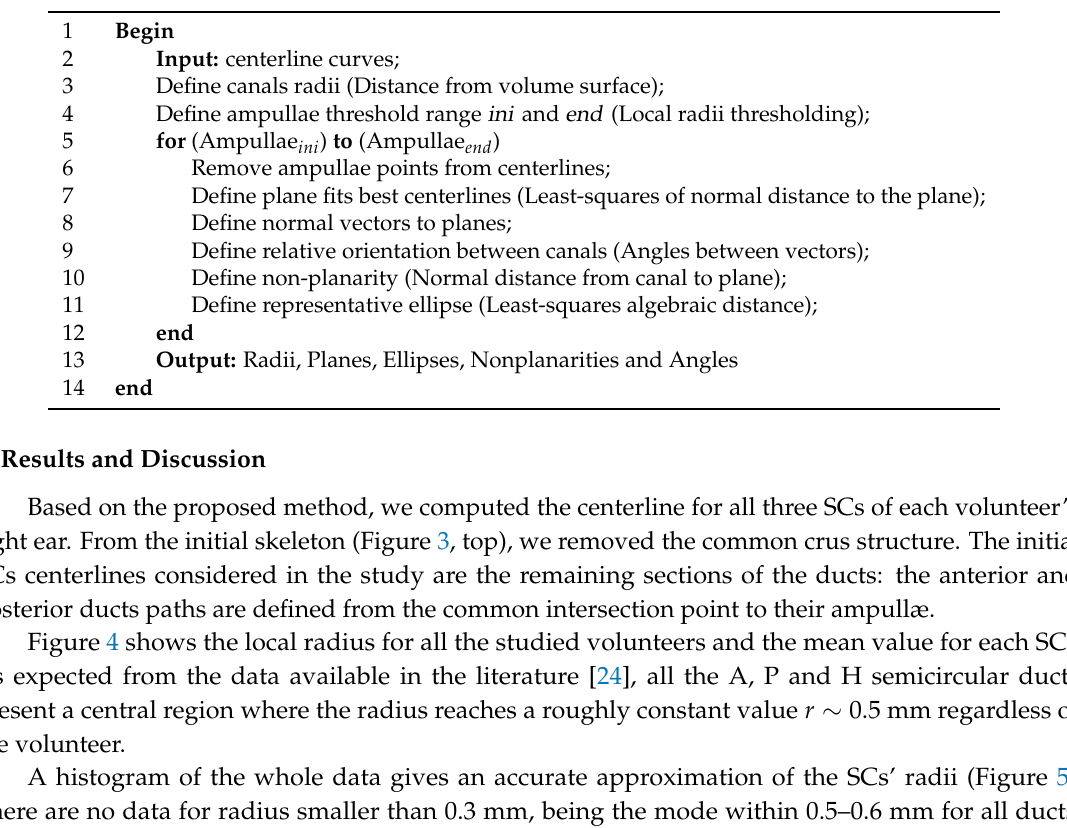
Table 3. Pseudo-code of morphological characterization.